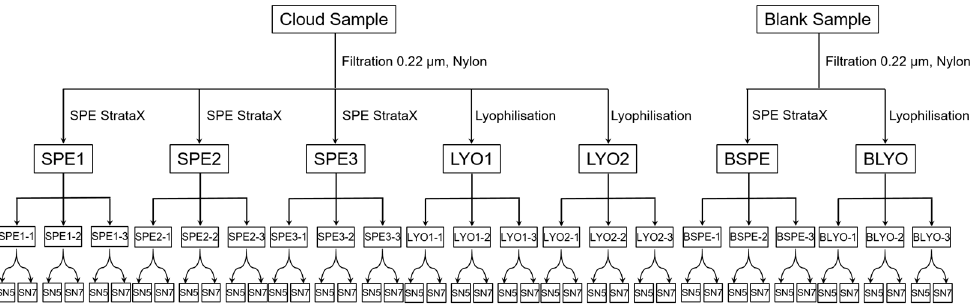
Figure 1. Schema of the experiment. SPE = solid phase extraction, LYO = lyophilization; BSPE = blank SPE; BLYO = blank LYO; SN = signal-to-noise ratio (S/N).